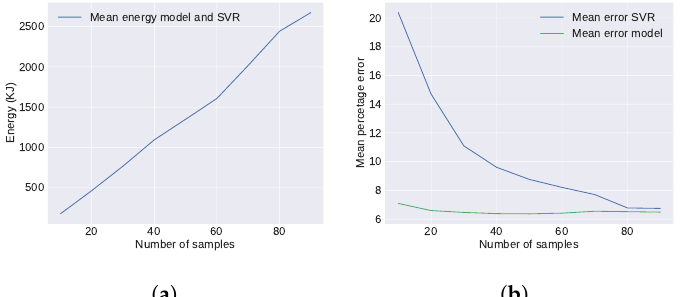
Figure 11. Overall results for energy and MPE for each training size. ( a ) Average energy spent on all applications during model creation. The two curves are identical because the same data were used to adjust the SVR and the model. ( b ) MPE of all applications: SVR needs 10 times more data to have an MPE lower than the proposed